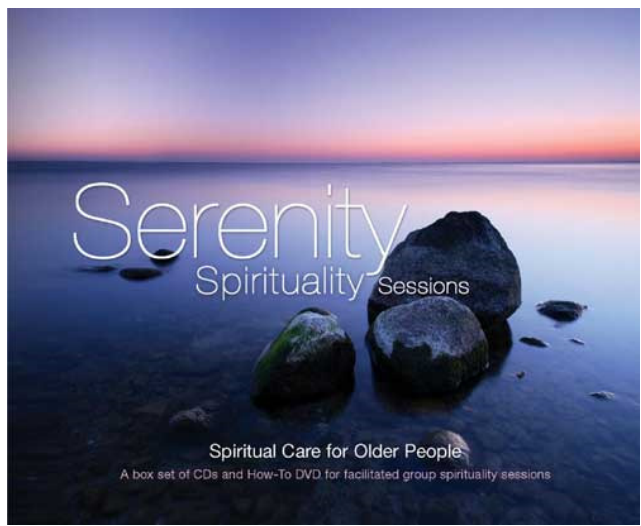
Figure 1. Front cover of Serenity Spirituality Sessions explanatory